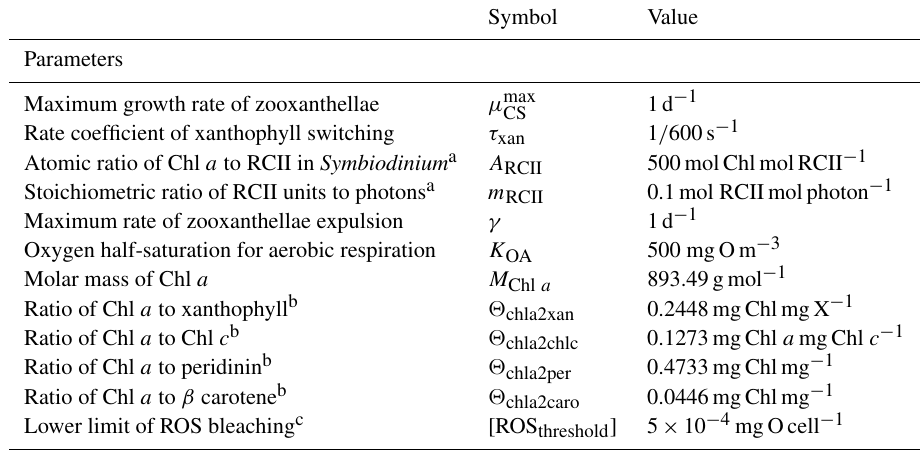
Table 31. Constants and parameter values used in the coral bleaching model. “RCII” indicates the reaction centre of photosystem